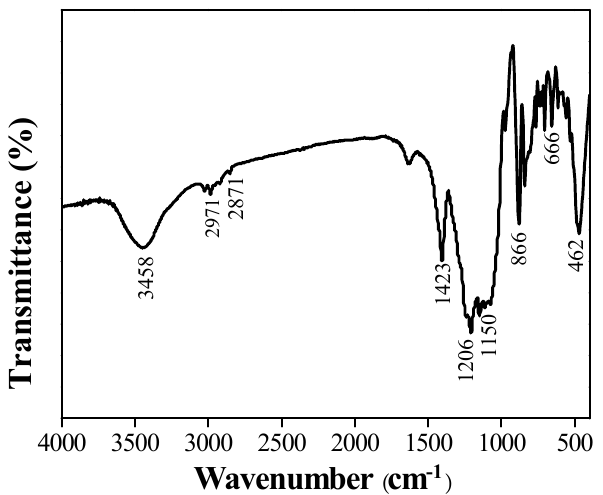
Figure 4. FTIR spectrum of PVDF/PFOTES–SiO 2 superhydrophobic surface.